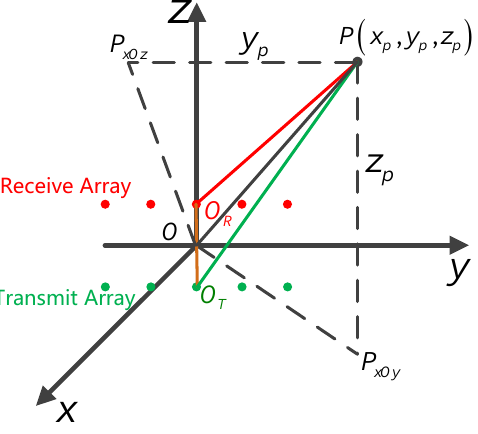
Figure 6. 3D Geometric model of MIMO imaging radar array. Sensors 2017 , 17 , 598